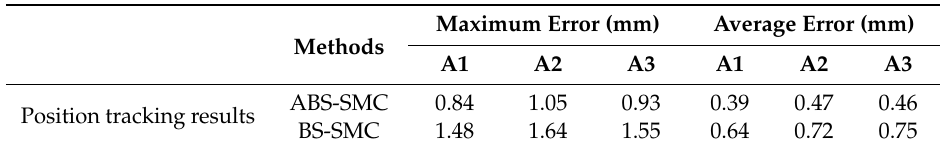
Table 1. Statistical analysis of actuator position tracking errors under different control methods (without subject).